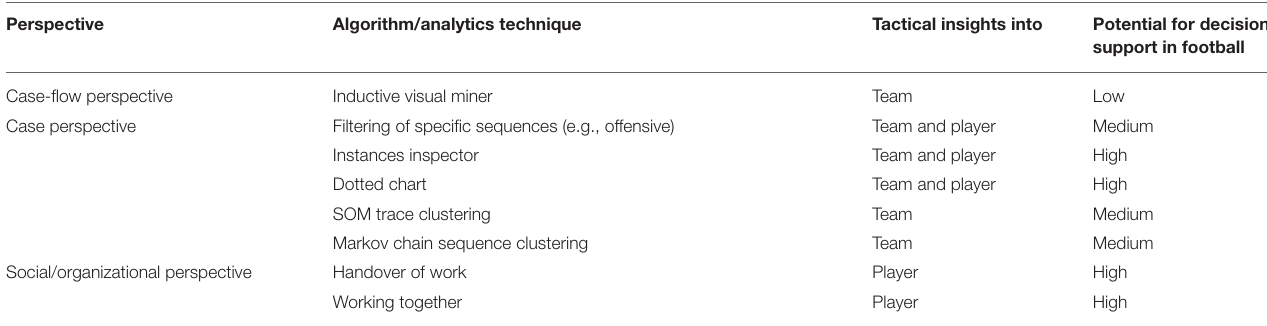
TABLE 5 | Process mining techniques and their insights in football.